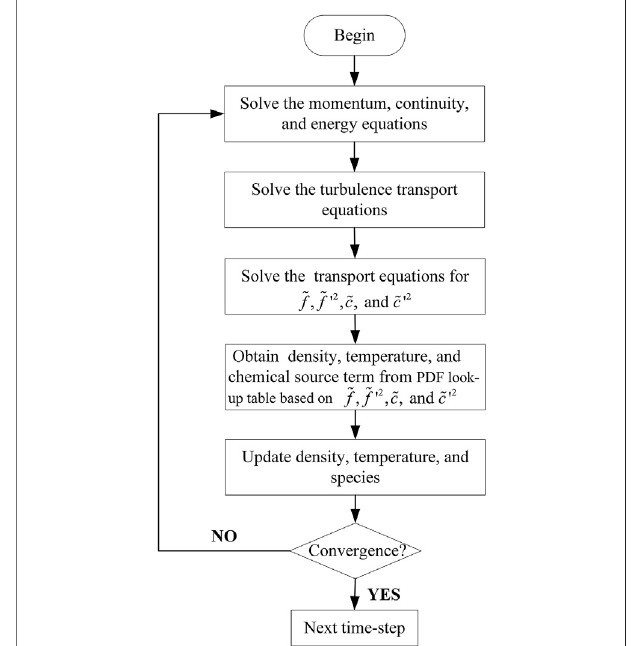
FIGURE 2 | Flowchart of one-time step of the numerical program for the present model (only four specie transport equations were solved, which massively decrease computational cost compared to previous numerical simulations (Smith et al., 2008; Smith et al., 2010a; Smith et al., 2010c; Smith,